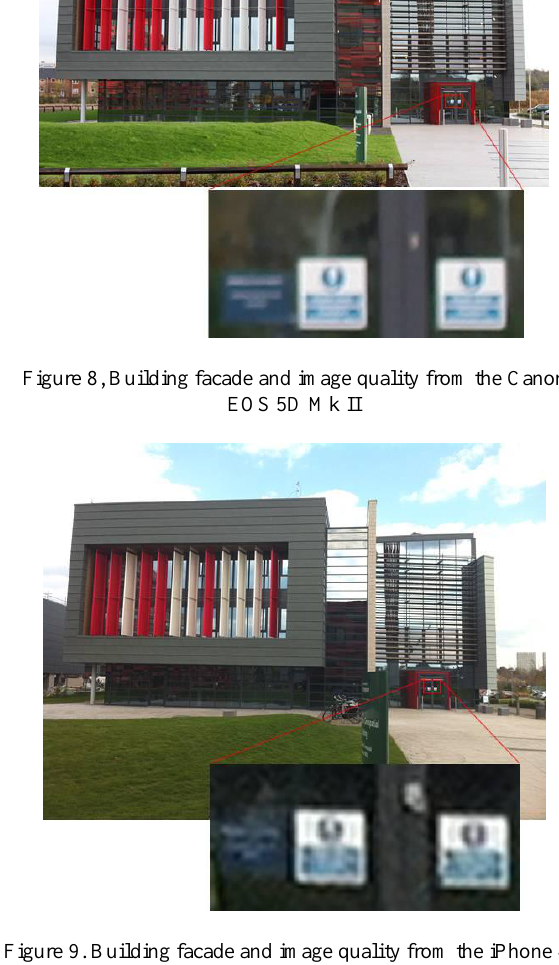
Figure 9. Building facade and image quality from the iPhone